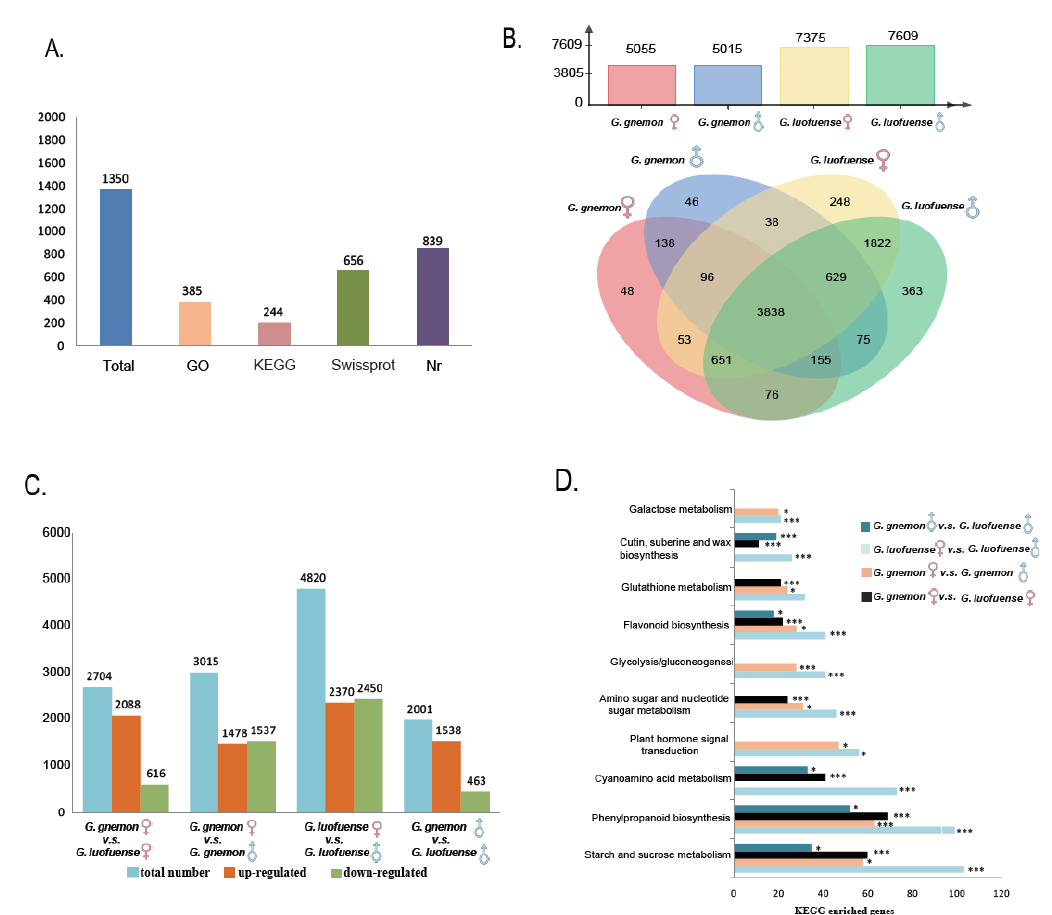
Figure 3. Transcriptomic data of reproductive organs in Gnetum . ( A ) Number of newly detected genes annotated against di ff erent databases. ( B ) Gene number detected in the fertile reproductive units (FRUs) and sterile reproductive units (SRUs) of G. gnemon and G. luofuense (above) and a Venn graph (below), revealing the identical and differential genes between the FRUs and SRUs of the two species. ( C ) Infra- and interspecific variation of differentially expressed genes (DEGs) between the FRUs and SRUs of G. gnemon and G. luofuense . ( D ) These DEGs enriched in the top 10 KEGG pathways; * represents P values < 0.05, ***denotes corrected P values < 0.05.